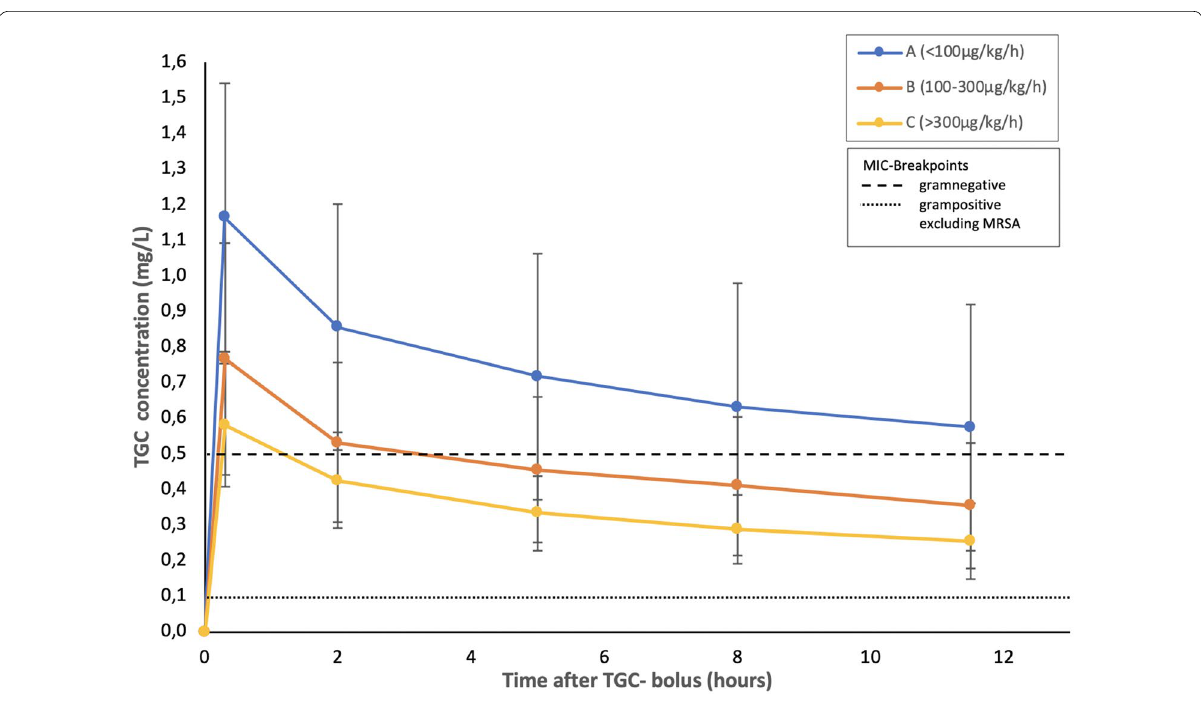
Fig. 2 Mean TGC plasma concentrations depending on the degree of liver failure. Data are presented as mean